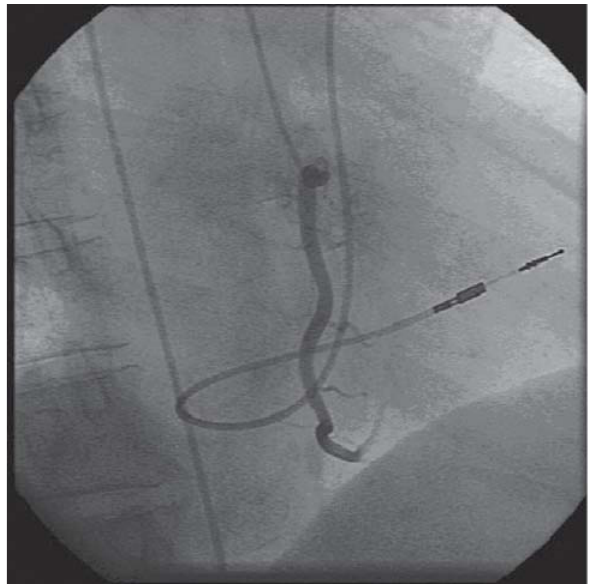
Fig. 2 - Eletrodo ventricular de fixação passiva, alocado em VD por meio de curvatura acentuada em AD, face sua passagem